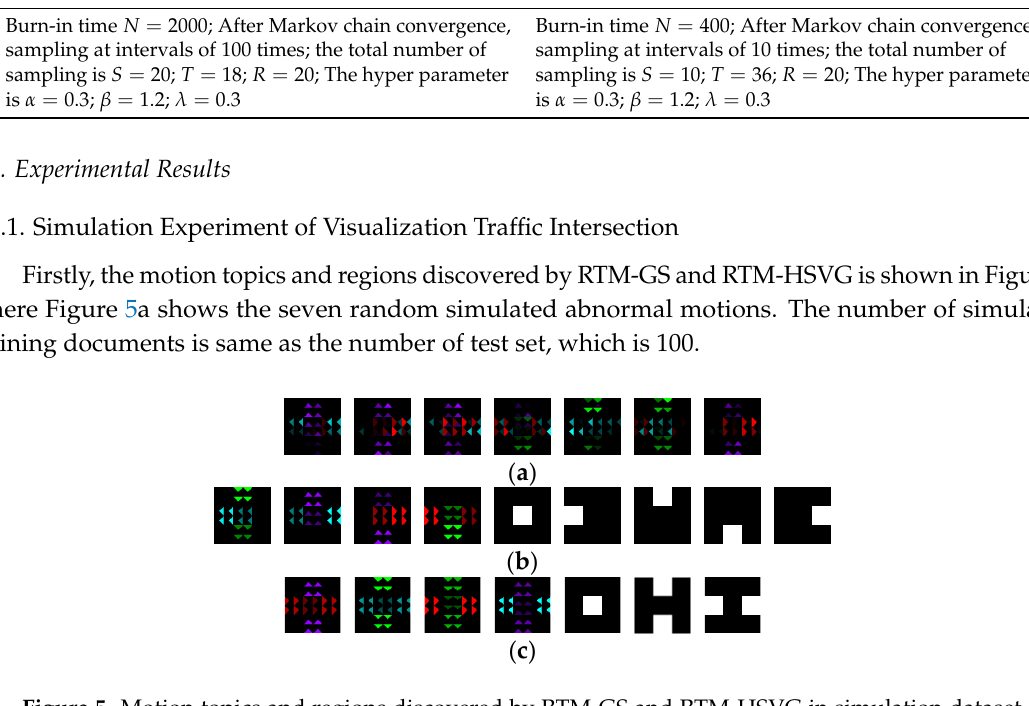
Figure 5. Motion topics and regions discovered by RTM-GS and RTM-HSVG in simulation dataset ( a ) The seven random simulate abnormal motions. ( b ) The four motion topics and five regions discovered by RTM-GS. ( c ) The four motion topics and three regions discovered by RTM-HSVG.